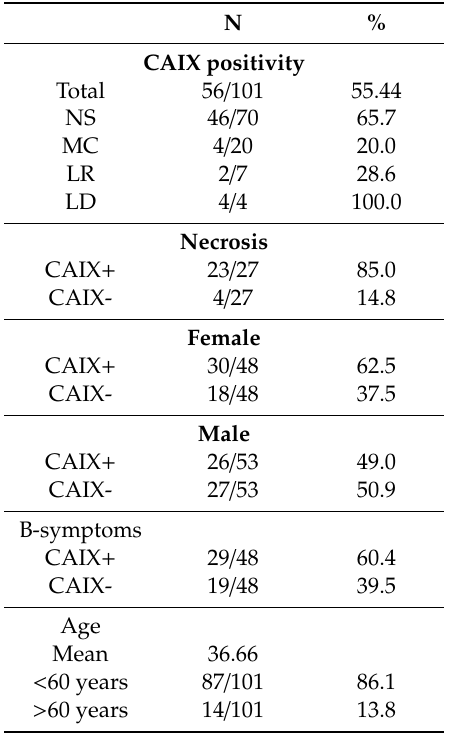
Table 1. Characteristics of the 101 cHL cases evaluated for CAIX and CD30 immunopositivity by both light microscopy and digital image analysis (H-score). N: number, CAIX: Carbonic anhydrase, cHL: classical Hodgkin’s lymphoma, NS: Nodular sclerosis, MC: Mixed cellularity, LR: Lymphocyte rich, LD: Lymphocyte